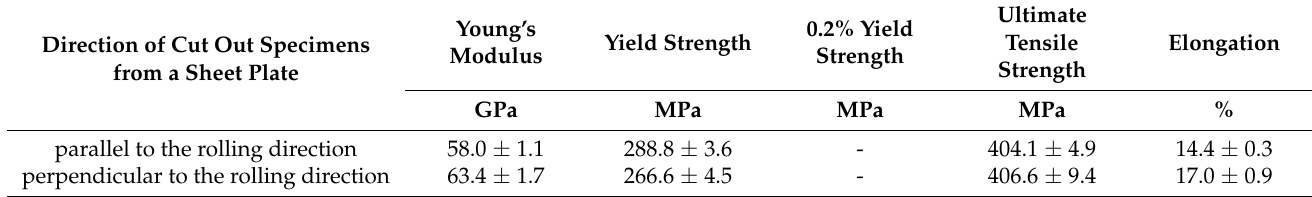
Ultimate 0.2% Yield Young’s Tensile Elongation Yield Strength Strength Modulus Strength GPa MPa MPa %